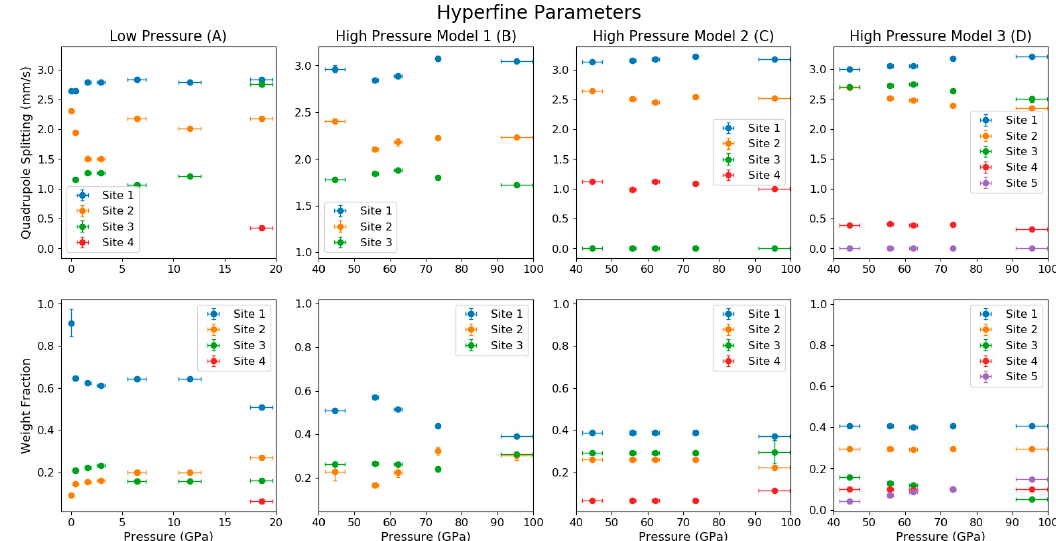
Figure 4. Fitted hyperfine parameters of szomolnokite as a function of pressure: quadrupole splitting and weight fractions of the iron sites. ( A ) Low pressure values, as all models are identical from 0 to 19 GPa. ( B ) Model 1 features only 3 sites from 45 to 95 GPa and assumes all the iron in the material remains in the high-spin state. ( C ) Values from Model 2, featuring a high- to low-spin transition in site 3 (quadrupole-splitting of 0 mm/s) between 19 and 45 GPa. ( D ) Values from Model 3 consider a gradual high-spin (site 3) to low-spin (site 5) transition from 45 to 95 GPa: site 3 (green) and site 5 (purple) trade off in weight fraction until site 3 has zero weight fraction and site 5 reaches a weight fraction around 0.2. Values are reported in Tables S2–S4.